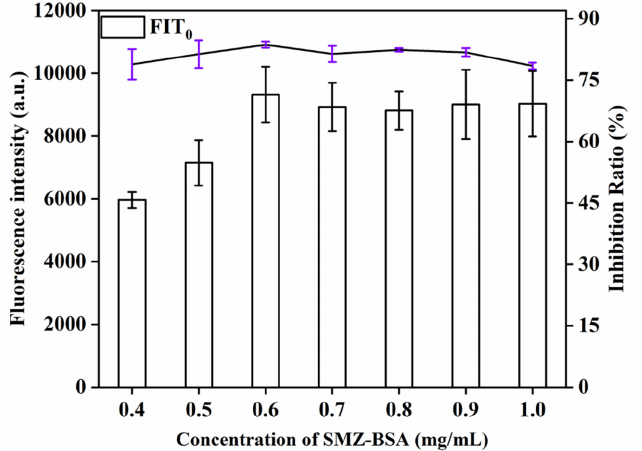
Figure 5. Optimization detection conditions of QBs-LFIA. Effects of concentration of SMZ–BSA.